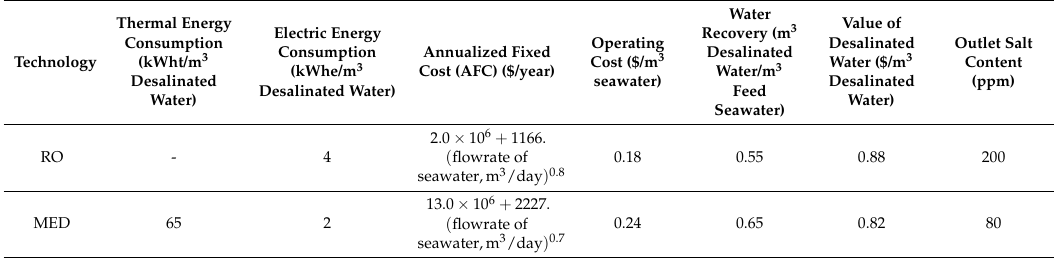
Table 1. Techno-economic data for RO and MED [32,50].